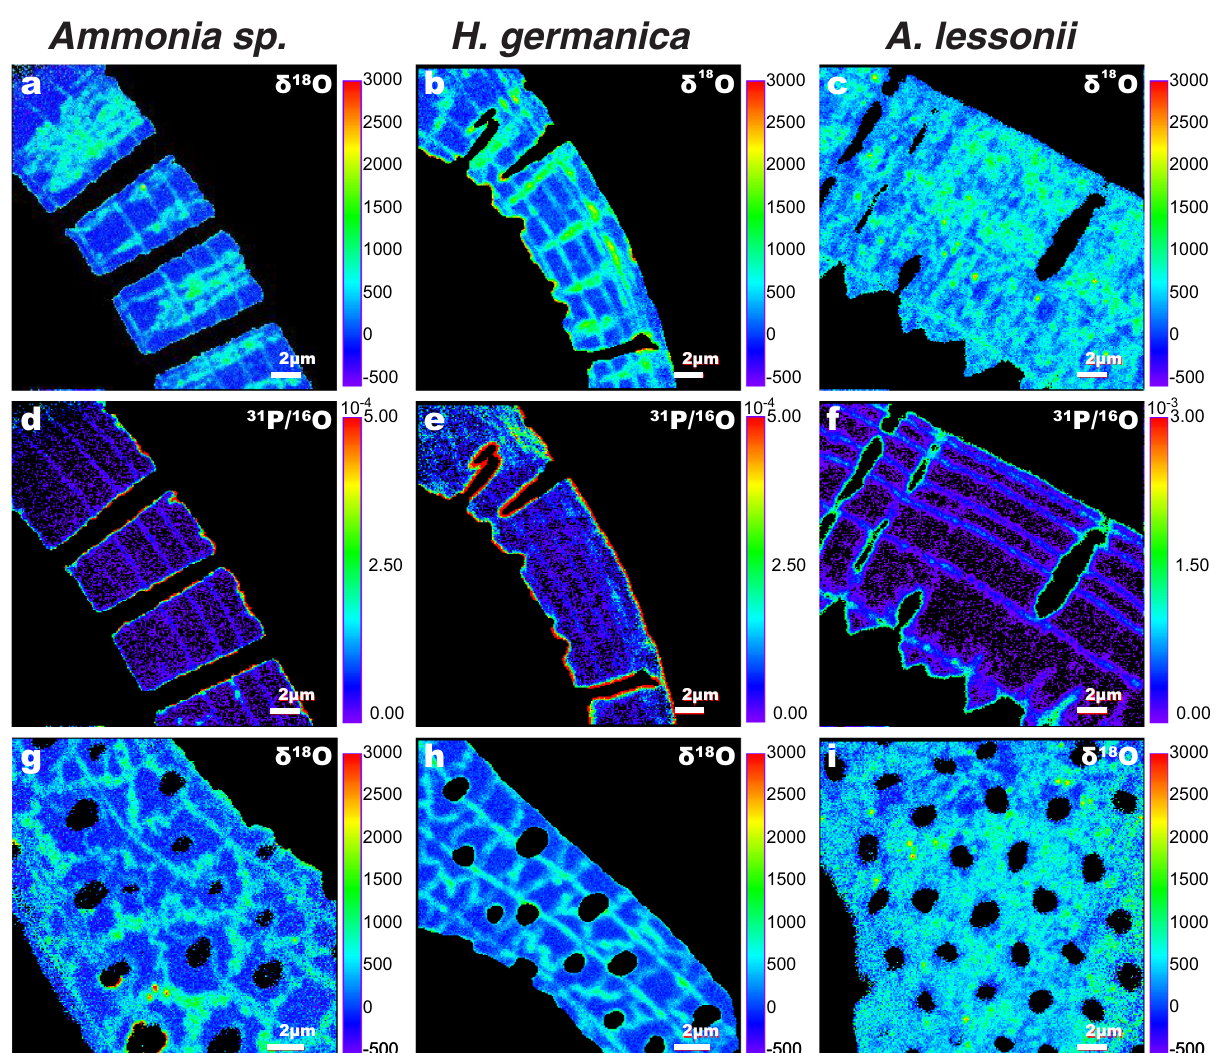
Fig. 4 Direct imaging of 18 O-enrichments in foraminifera tests after incubation. NanoSIMS images of Ammonia sp., H. germanica, and A. lessonii tests after incubation for 6 days at 90 °C in seawater analogue with a 18 O/ 16 O ratio of 0.30. a – c Surfaces exposing the interior of test walls show high 18 O-enrichments occurring as thin parallel bands following the curvature of the test walls and elongated zones of variable thickness running perpendicular to the test surface. d – f Same view of the same samples showing the 31 P/ 16 O ratio, which reveals P-rich bands following the curvature of the test walls. g – i Surfaces from the interior of the same samples, but cut parallel to the wall surface, show 18 O-enrichments occurring as thin, tortuous and cogwheel- shaped lines in Ammonia sp. and H. germanica , which merge into patchy areas of higher 18 O enrichment in A. lessonii